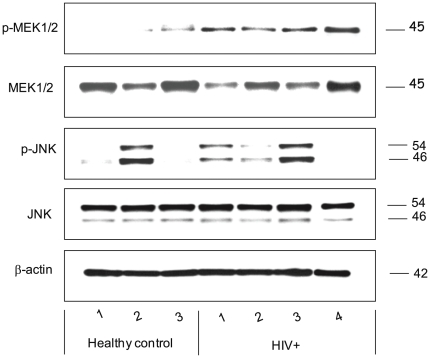
Endogenous levels of MEK1/2, JNK1/2, p-MEK1/2, and p-JNK, predicted to be activated by IPA, assayed by immunoblotting.The blots were probed with antibodies specific to MEK1/2 and JNK and phosphospecific antibodies to their phosphorylated counterparts in the total lysates indicated from left: Healthy controls (1–3); HIV+ (1–4), HIV-infected subjects, with subjects in HIV+ lanes 1 and 4 HAART naïve while 2 and 3 are on HAART (see also Table S1, subjects 8–11).